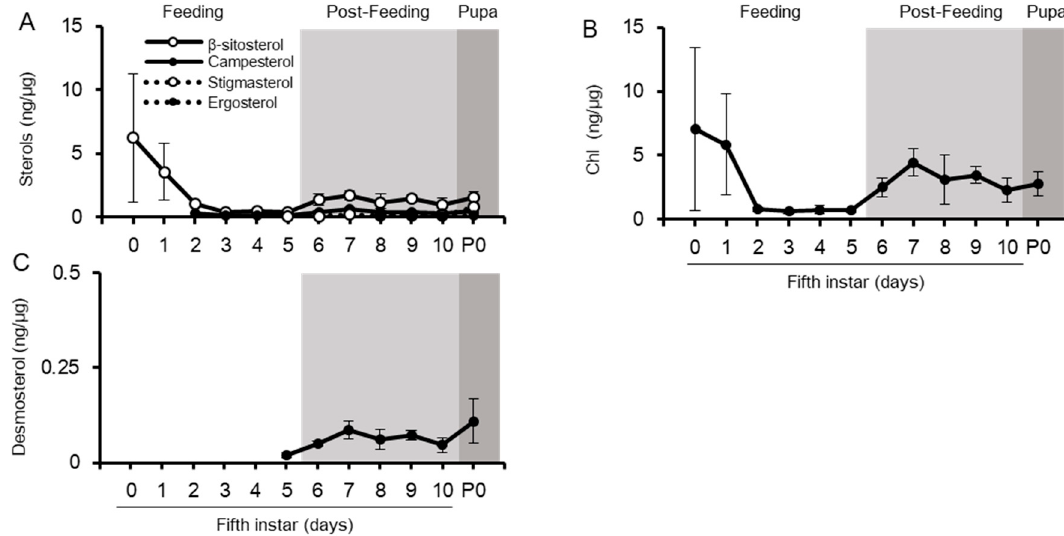
Figure 6. Changes in sterol amount in the fat body from the final instar stage to pupal periods. The amount of dietary sterols ( A ), Chl ( B ), and desmosterol ( C ). Each sterol amount was normalized using the protein amounts of respective samples. Values are mean ± s.d. ( n = 3). P0: pupal stage day 0.